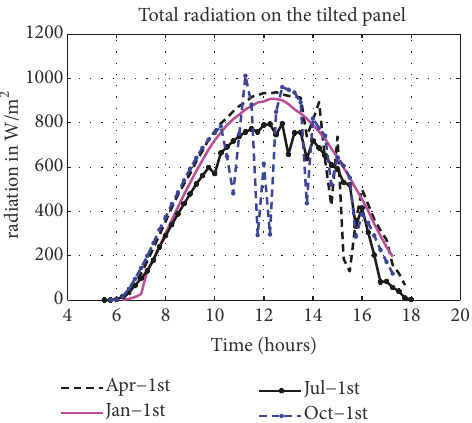
Figure 11: Hourly variation of PV module operating temperature.